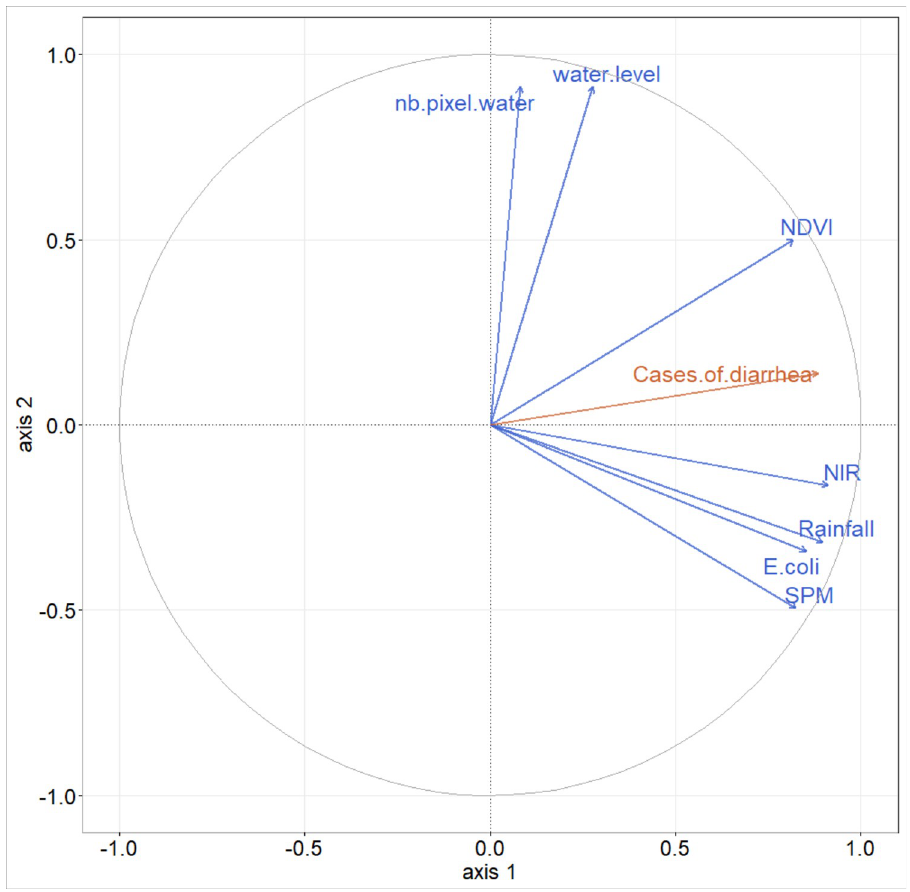
Fig 12. Correlation circle of partial least squares (PLS) regression, illustrating relationships between predictor variables (blue), cases of diarrhea (orange) and the two first PLS components (first component on the x-axis, second one on the